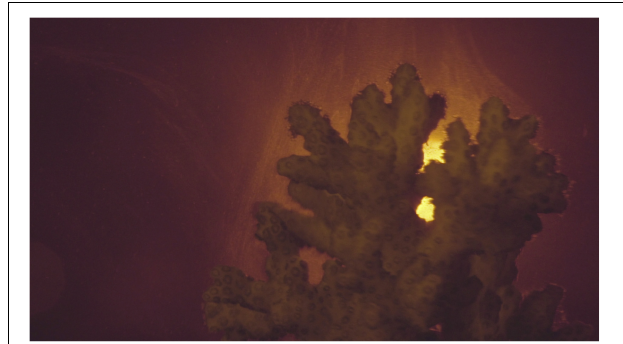
FIGURE 2 | Wisps of sperm were only visible when the red light source was placed directly behind the colony, creating a silhouette. Spawning was observed three times throughout the night during the time of peak planula release. See Video clip in Supplementary Material .